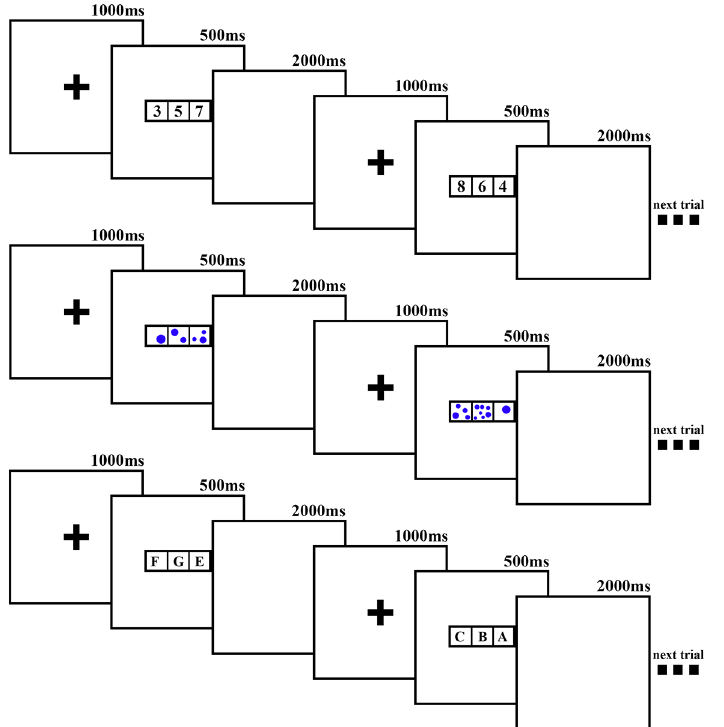
Figure 1. Examples of trial sequences for symbolic numbers, non-symbolic numbers and letters of the alphabet.